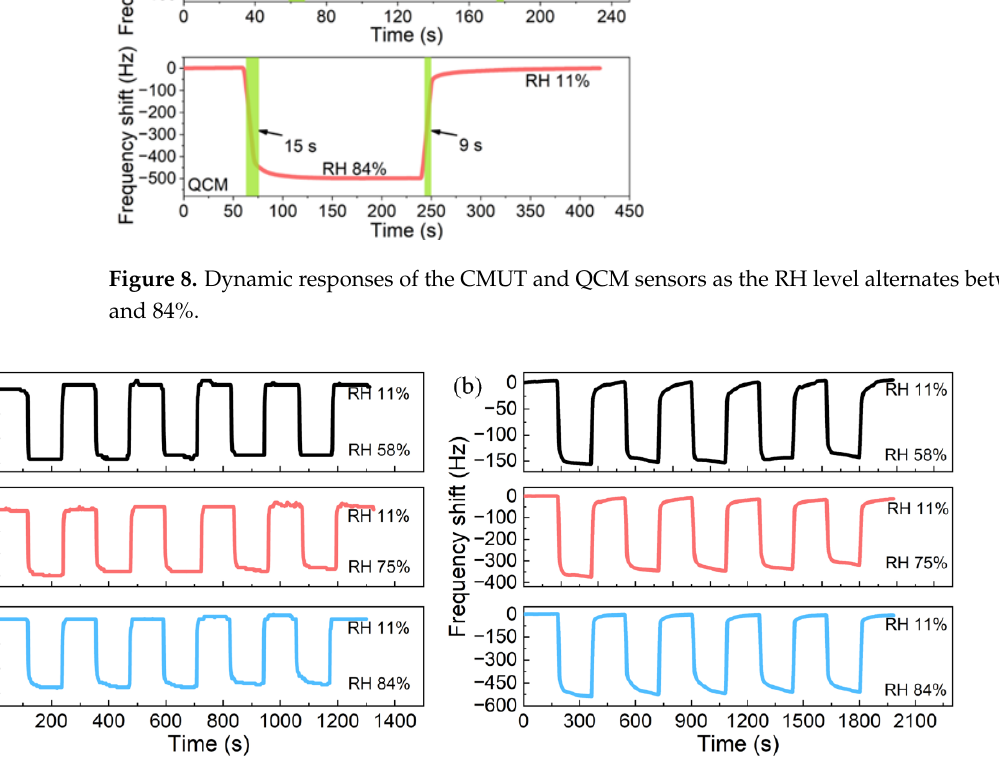
Figure 8. Dynamic responses of the CMUT and QCM sensors as the RH level alternates between 11% and 84%.